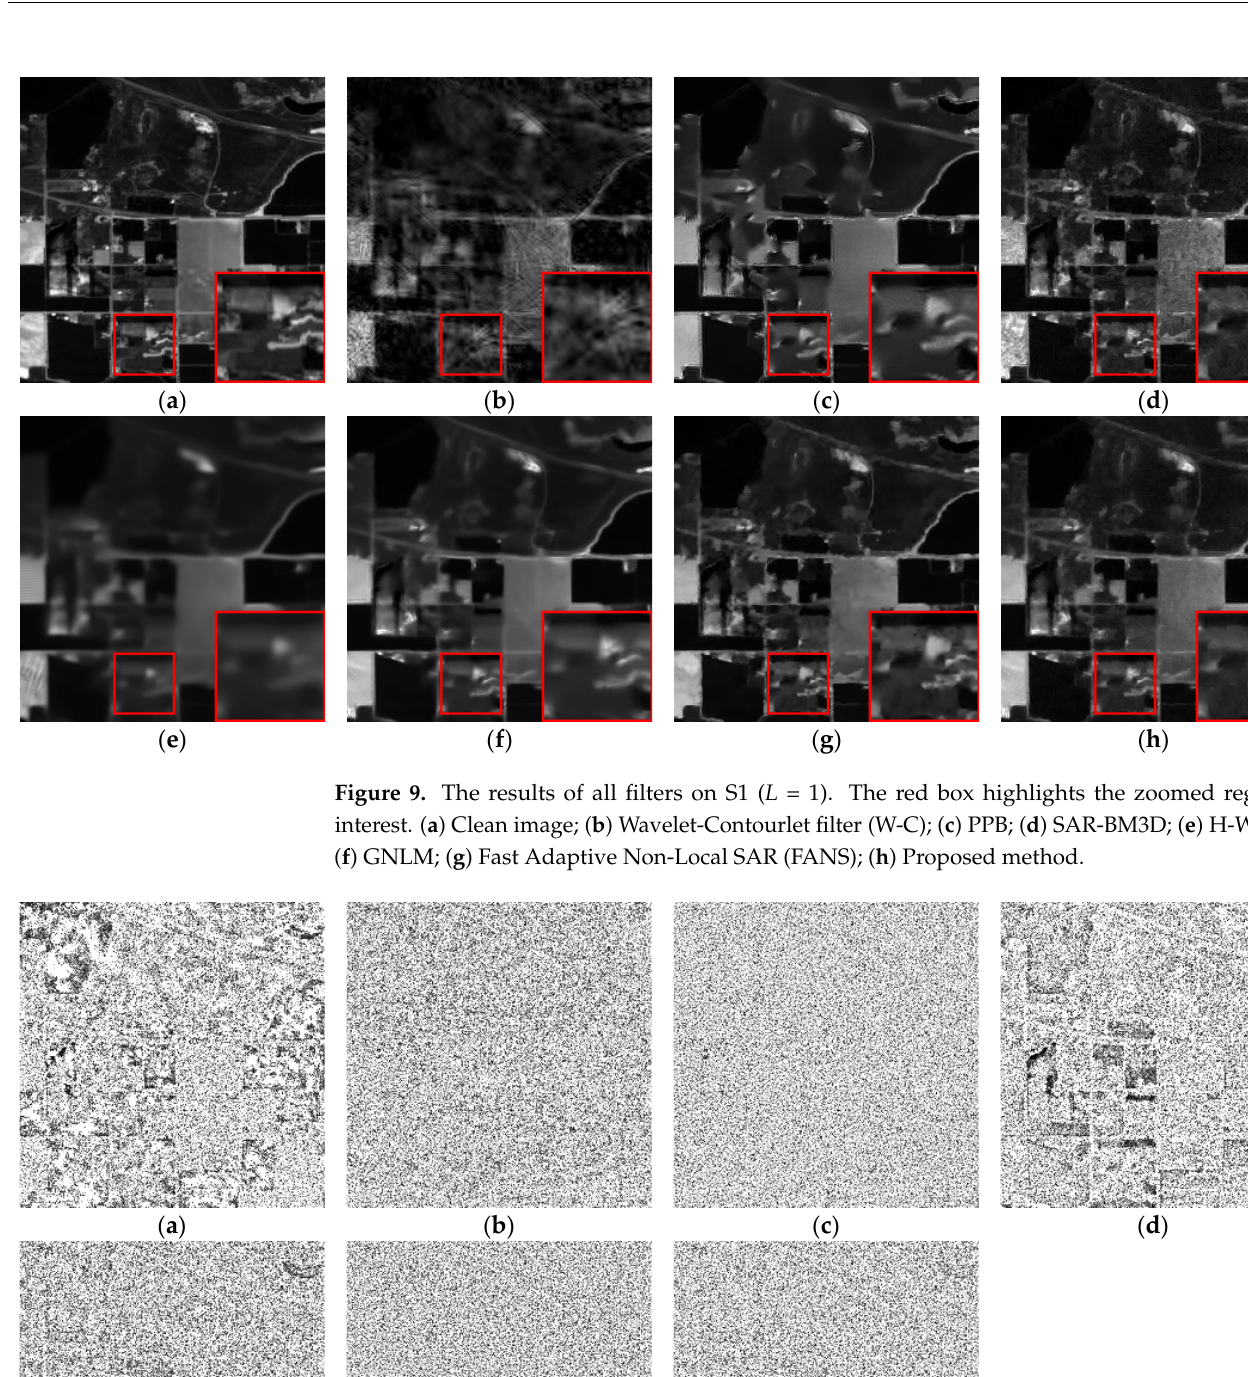
Table 3. The FSIM, PSNR, and ENL of all filters on the synthesized multiplicative noise images ( L = 1, 2, 4, 8).